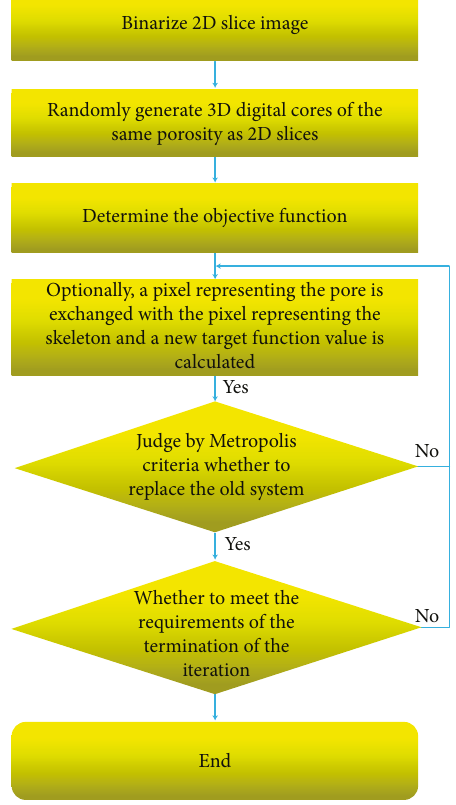
Figure 5: SA method reconstruction of 3D digital core